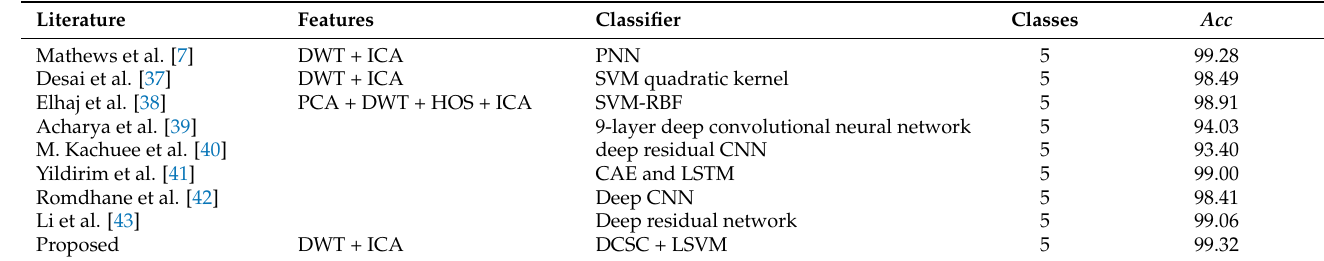
Table 5. Comparison of works on ECG heartbeat classification from